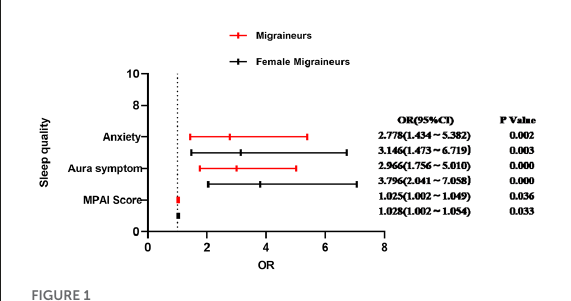
FIGURE1 Influencing factors of sleep quality in migraine and female migraine patients.